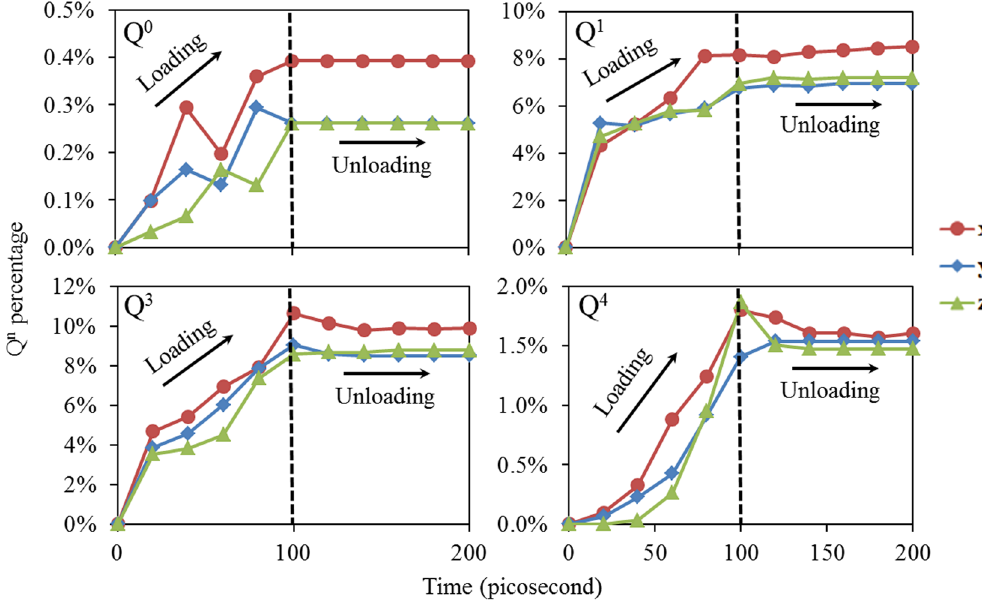
Figure 6. Time-dependent process of the phase transformations during nano-indentation with a 40 Å radius